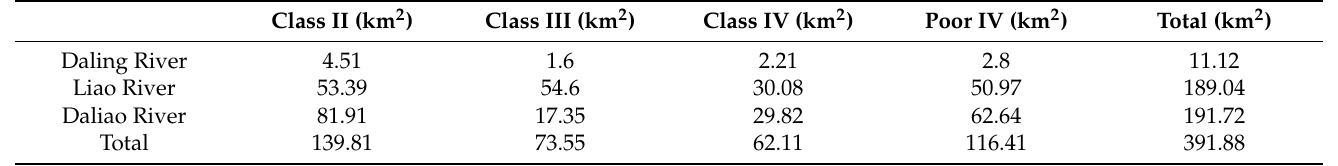
Table 4. Water quality area (COD) of major rivers entering the sea corresponding to various types of water in Liaodong Bay waters in August 2018.